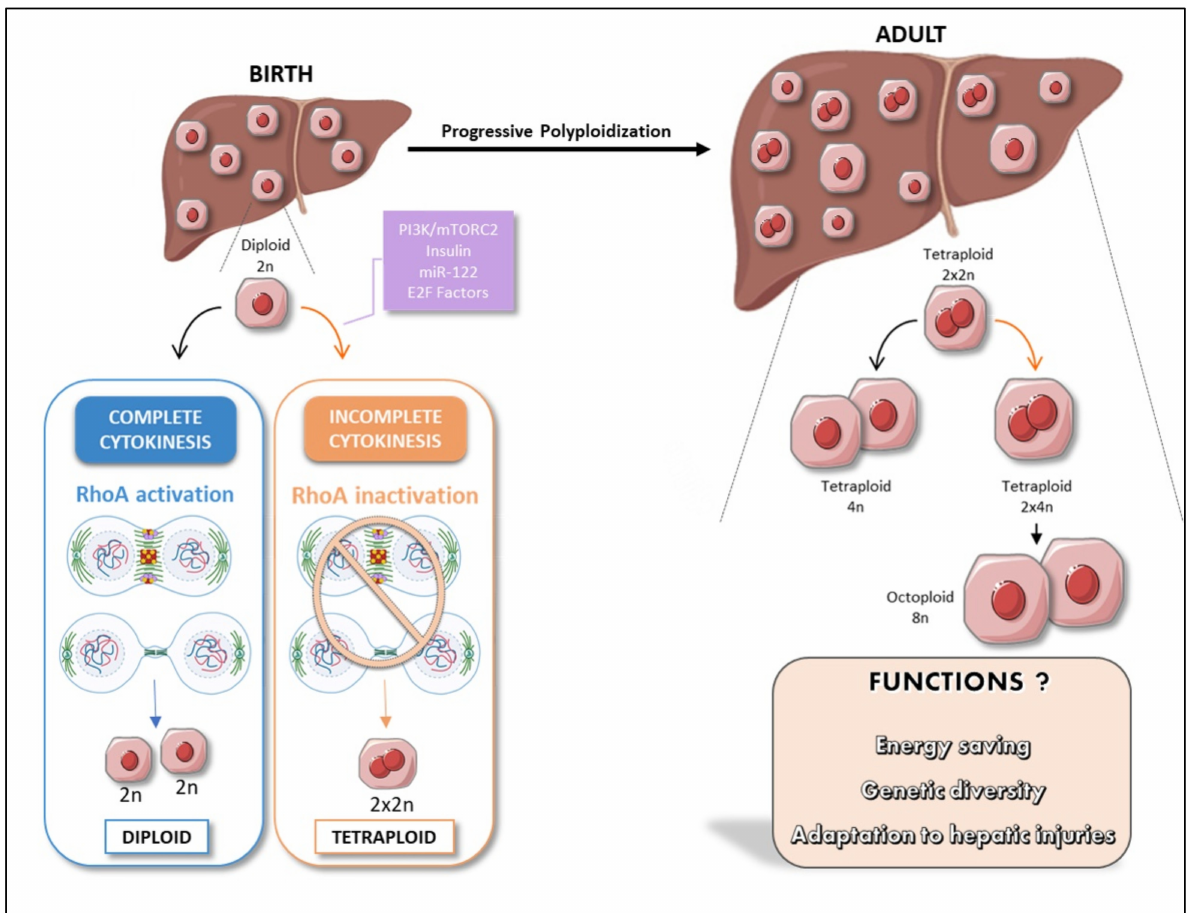
Figure 2. Physiological polyploidy in the liver during post-natal development. The hepatocytes of neonates are exclusively diploid (mononucleate 2 n). During weaning, diploid hepatocytes may undergo normal cell division cycle (blue box) giving rise to two diploid hepatocytes, or incomplete cytokinesis (orange box) driven by the impairment of Rho signaling, giving rise to one binucleate tetraploid hepatocyte. This developmental process is regulated by insulin, phosphoinositide 3-kinase (PI3K)-mechanistic target of rapamycin complex 2 (mTORC2), E2F and miR-122 signaling. This process leads to progressive polyploidization of the liver parenchyma during the course of postnatal development and the generation of tetraploid and octoploid hepatocytes with specific